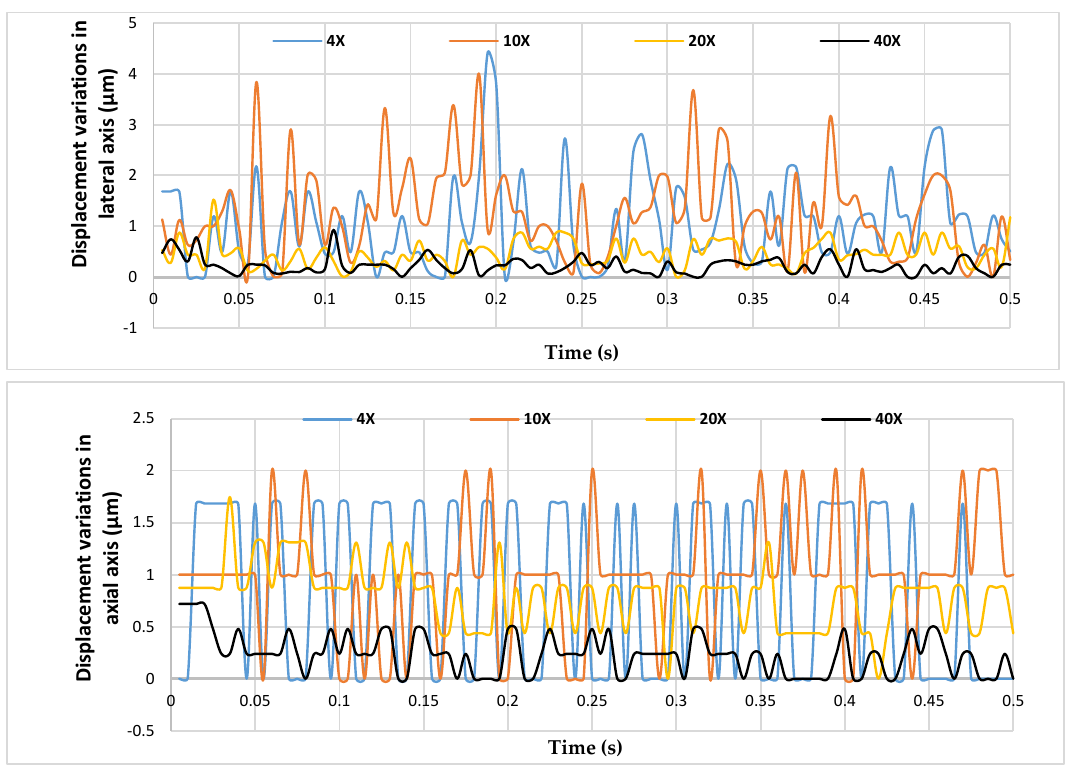
Figure 10. Displacement variations between developed vision sensor and Image J software in axial and lateral axes.